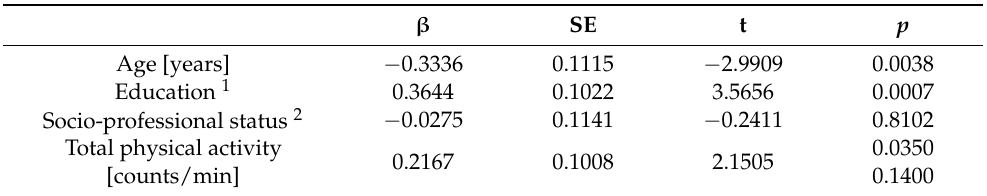
Table 13. Multivariate linear regression analysis assessing the relationship between MoCA points and selected variables in the total study population ( n =